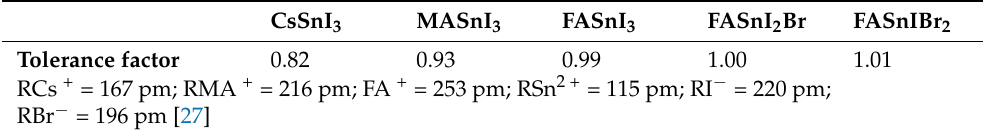
Table 1. Tolerance factor of tin halide